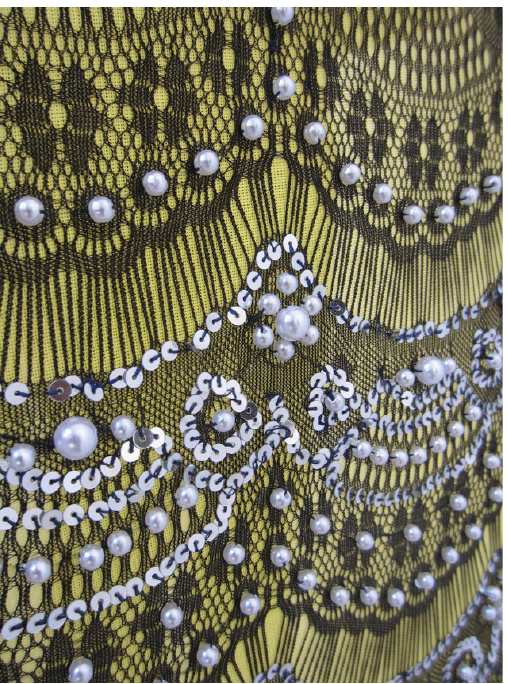
Chan Dany, Sampot: The Collection of Small Things (Raindrops on the Wave), 2012. Lycra, lace, plastic beads, sequins, cotton thread. 100cm x 150cm.